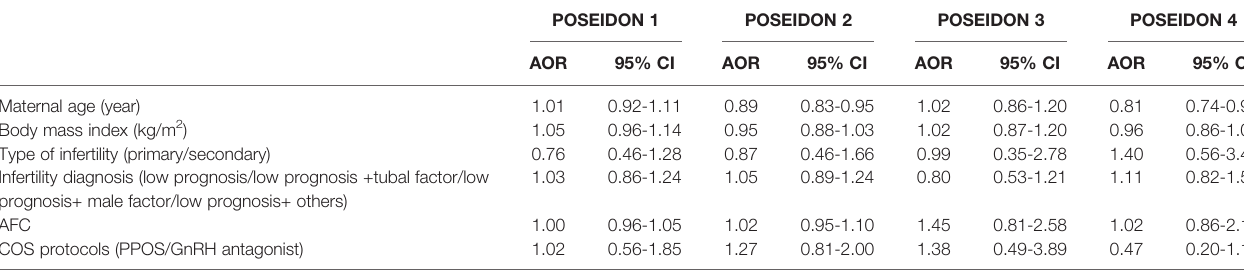
TABLE 3 | Binary logistic regression analysis to account for confounding variables affecting the cumulative live birth